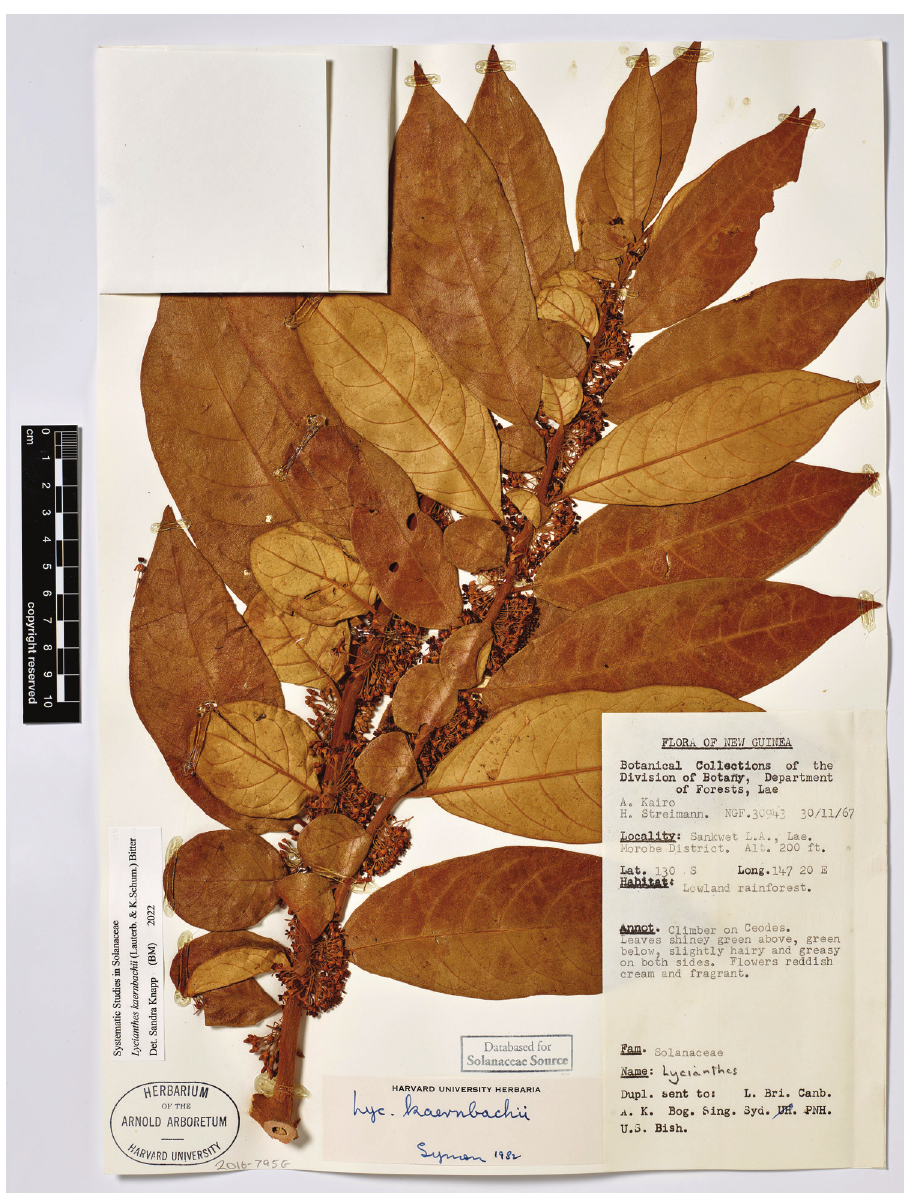
Figure 26. Lycianthes kaernbachii herbarium specimen. Papua New Guinea. Morobe: Kairo & Streimann NGF-30943 (A). Courtesy of the Herbarium of the Arnold Arboretum of Harvard University, reproduced with